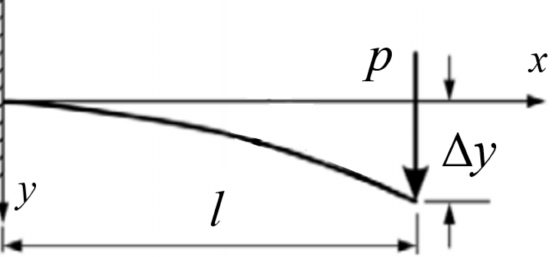
Figure 5. Schematic diagram of cross-arm’s beam when exposed applied force at the end of the cross-arm structure.